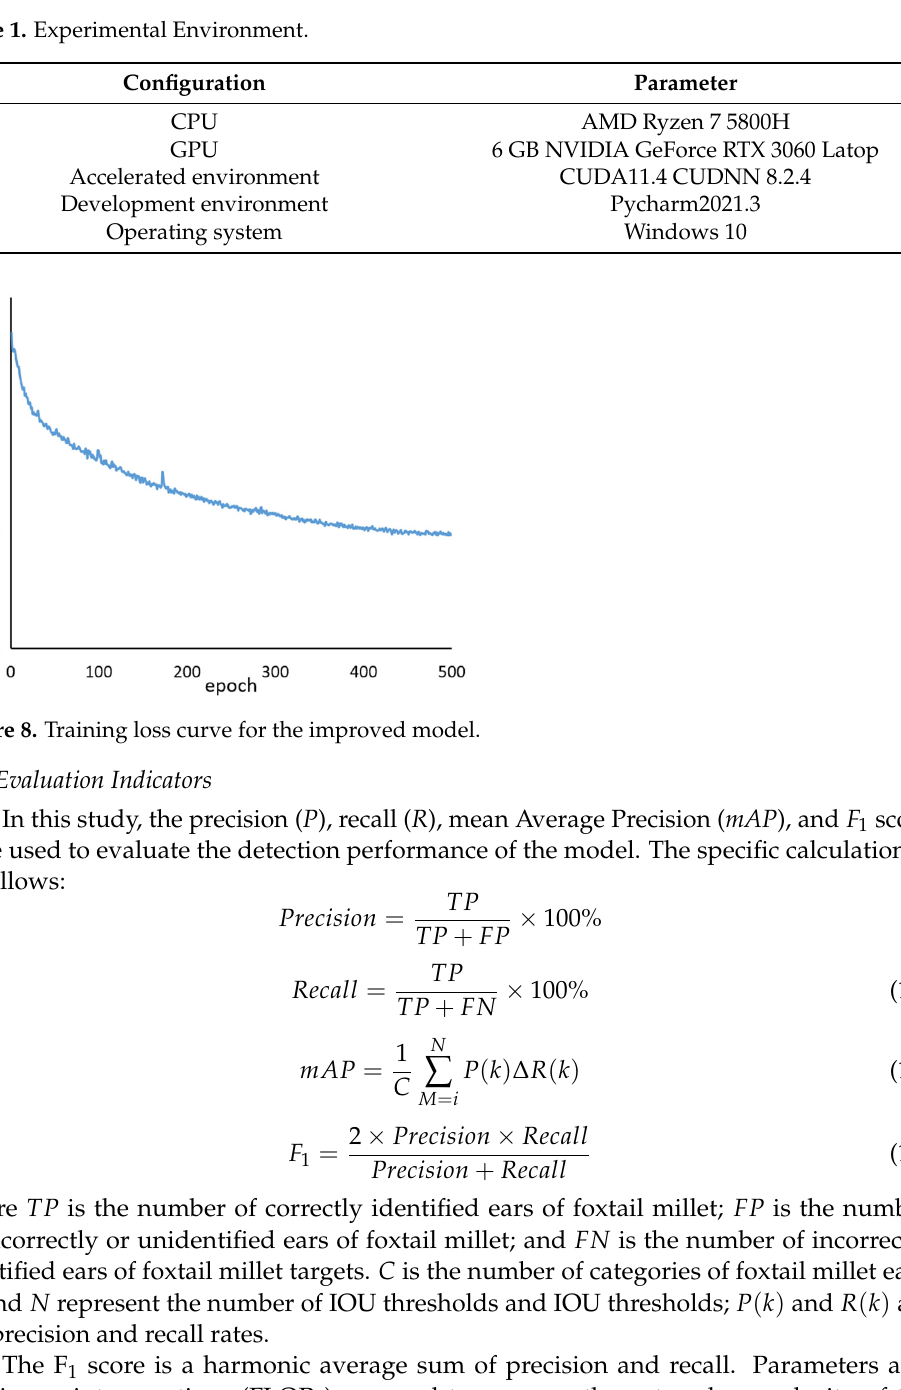
Table 1. Experimental Environment.